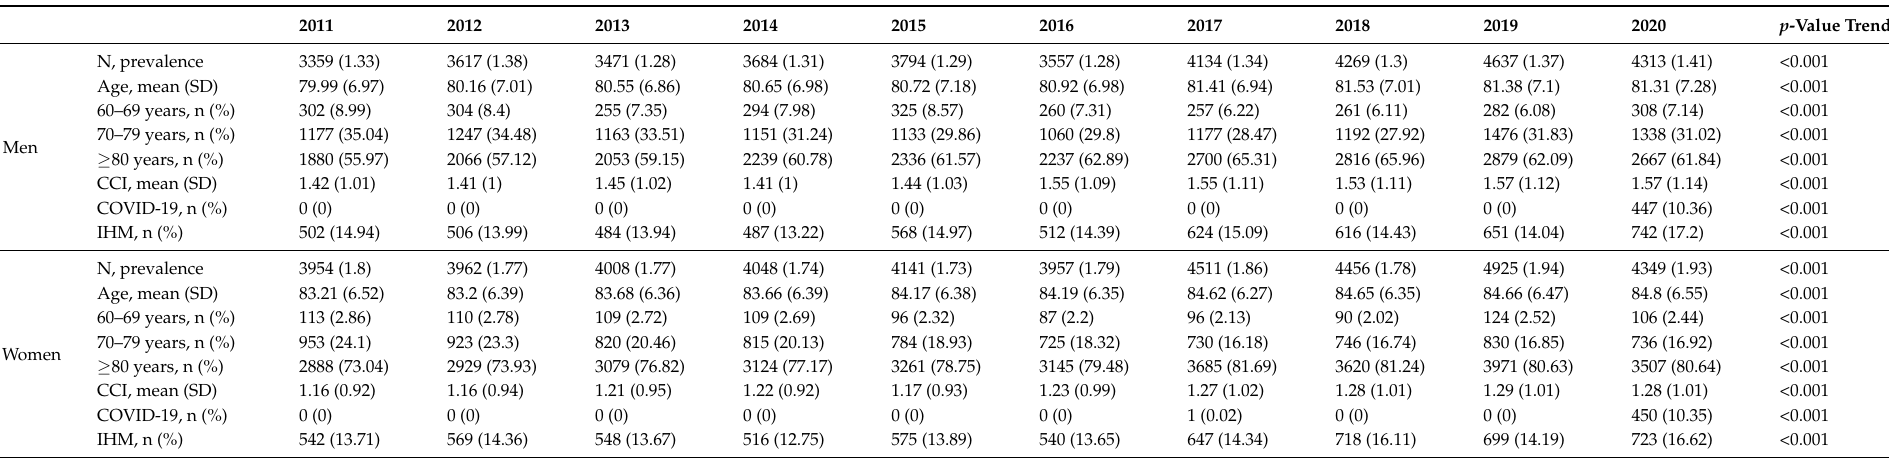
Table 4. Prevalence of vascular dementia. Distribution by age and clinical characteristics and in-hospital outcomes among men and women hospitalized with type 2 diabetes in Spain,